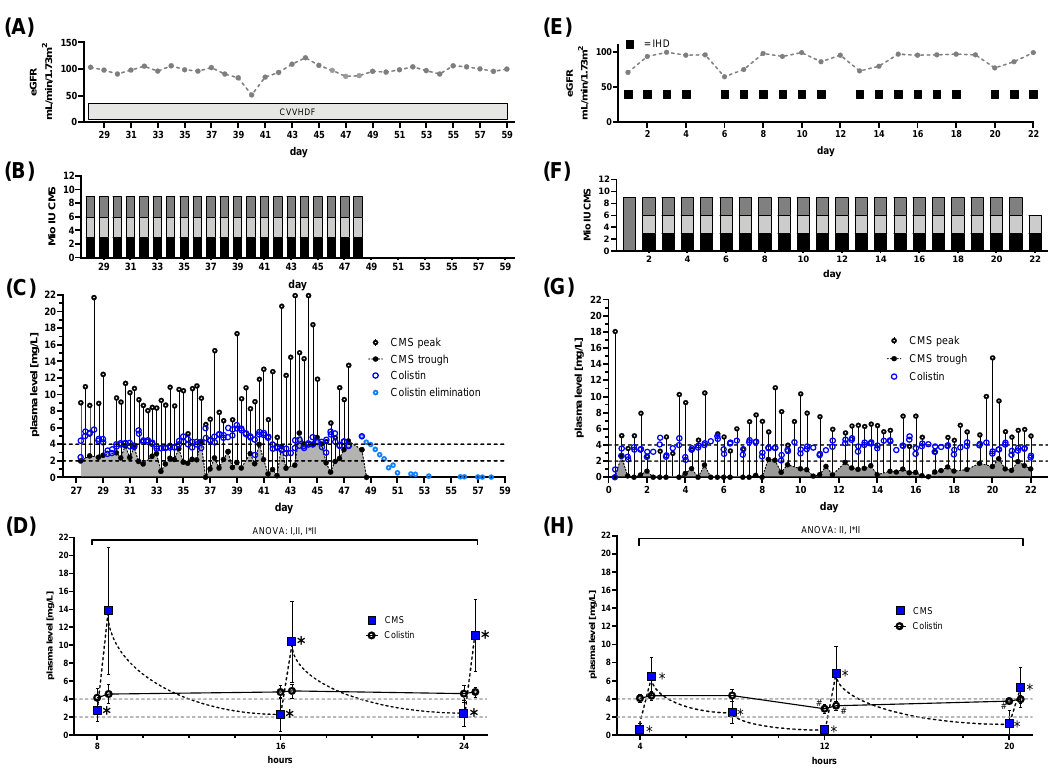
Figure 8. Renal function, dose regimen and drug plasma levels of patient 6: a total of 236 samples were analyzed. First treatment cycle (A)-(D): (colisthimethate sodium (CMS) peak n = 59, CMS trough n = 55, Colistin peak n = 62, Colistin trough n = 59). ( A ) estimated glomerular filtration rate (eGFR) derived from serum creatinine levels and renal replacement therapy (RRT) via continuous venovenous hemodiafiltration (CVVHDF). ( B ) Dose regimen used. Shaded blocks depict the particular individual doses each day. ( C ) Time course of CMS trough and peak levels along with Colistin levels. The CMS reservoir is indicated by the area gray shaded portion of panel ( C ). Colistin elimination was measured by continuing monitoring after the end of treatment (light blue dots) and the individual fitted elimination is plotted in Figure 1A. Target range for Colistin plasma levels is indicated by dashed lines. ( D ) Pooled data of daily administrations of CMS or Colistin levels plasma levels during all days with RRT during the first treatment cycle. ( E – H ): CMS peak n = 56, CMS trough n = 59, Colistin peak n = 59, Colistin trough n = 56. ( A ) eGFR derived from serum creatinine levels and RRT via intermittent hemodialysis (IHD). ( F ) Dose regimen used. Shaded blocks depict the particular individual doses each day. ( G ) Time course of CMS trough and peak levels along with Colistin levels. The CMS reservoir is indicated by the area gray shaded portion of panel ( G ). Target range for Colistin plasma levels is indicated by dashed lines. ( H ) Pooled data of daily administrations of CMS or Colistin levels plasma levels during all days with RRT during the second treatment cycle. Statistics Panel ( D ): mean ± SD; repeated measures ANOVA. E ff ect I: Di ff erences between CMS and Colistin levels, p = 0.0095. E ff ect II: time e ff ect, p < 0.0001. I*II: interaction of e ff ects I&II, p < 0.0001. Post-hoc tests: * p < 0.05 vs. previous CMS plasma level. Panel (H): mean ± SD; repeated measures ANOVA. E ff ect I: Di ff erences between CMS and Colistin levels, n.s. E ff ect II: time e ff ect, p < 0.0001. I*II: interaction of e ff ects I&II, p < 0.0001. Post-hoc tests: # p < 0.05 vs. previous Colistin plasma level, * p < 0.05 vs. previous CMS plasma level.